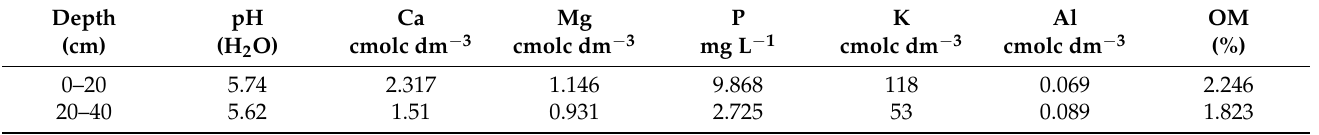
Table 1. Soil analysis in the experimental area at depths of 0–20 cm and 20–40